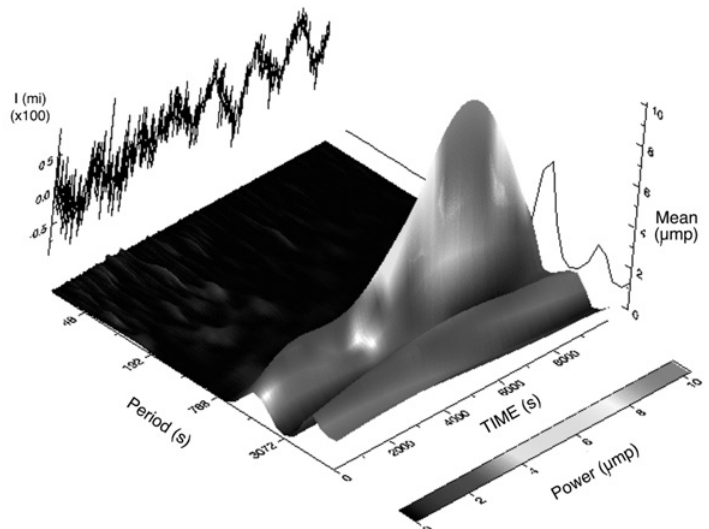
Fig. 4. The wavelet analysis of the July 24 data: a 3D representation of the result using the Morlet wavelet.